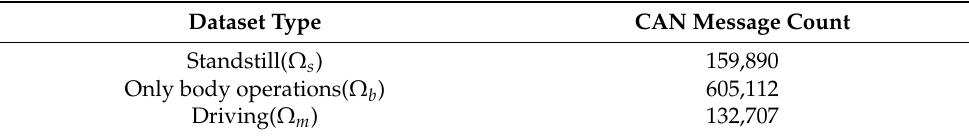
Table 3. Datasets and message